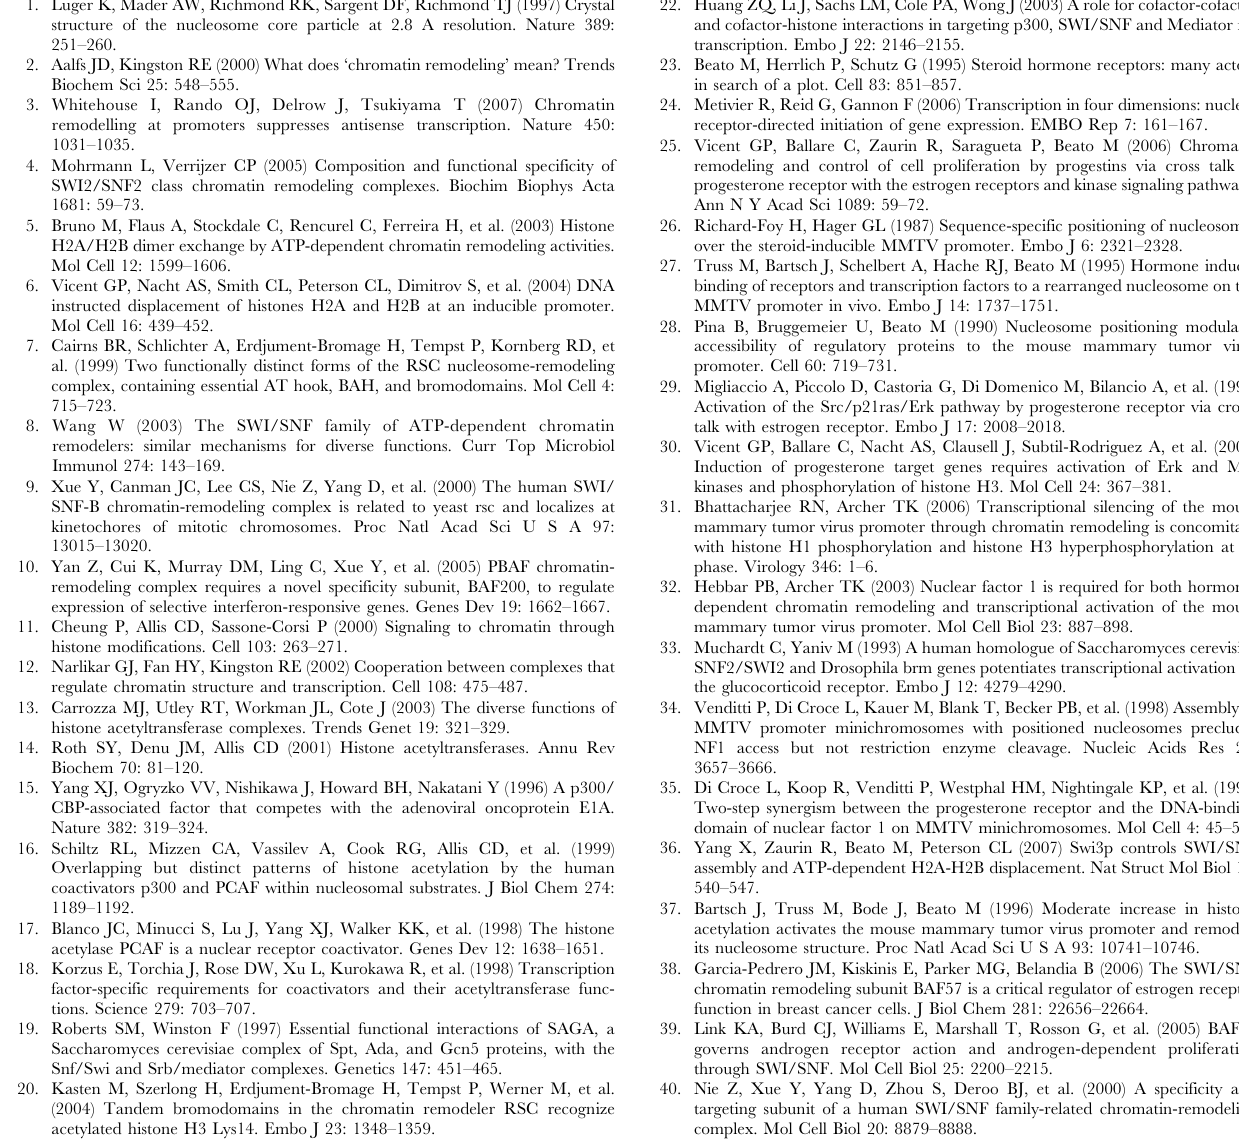
Figure S5 siRNAs and antibodies used for ChIP assays in the present